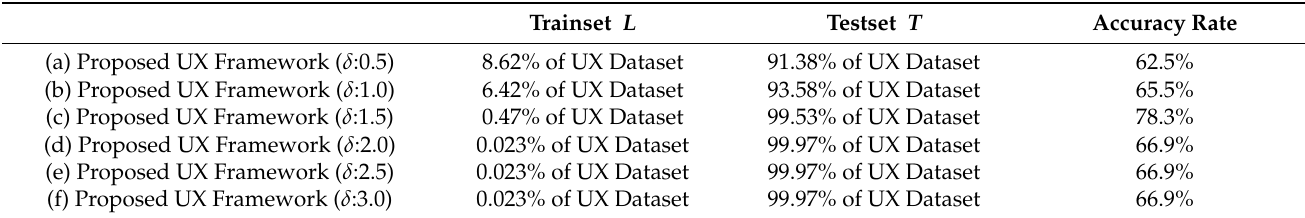
Table 1. Results of CNN—of ANN-based clustering methods of user #1. Trainset L Testset T Accuracy